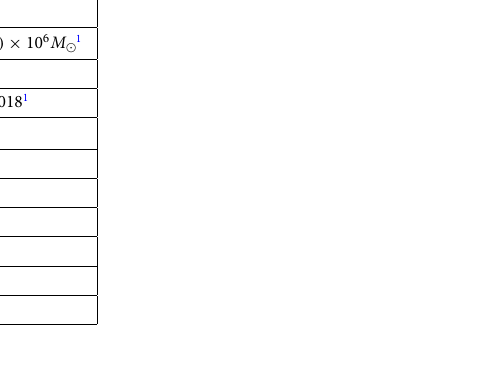
Table 1. Parameters of the S2